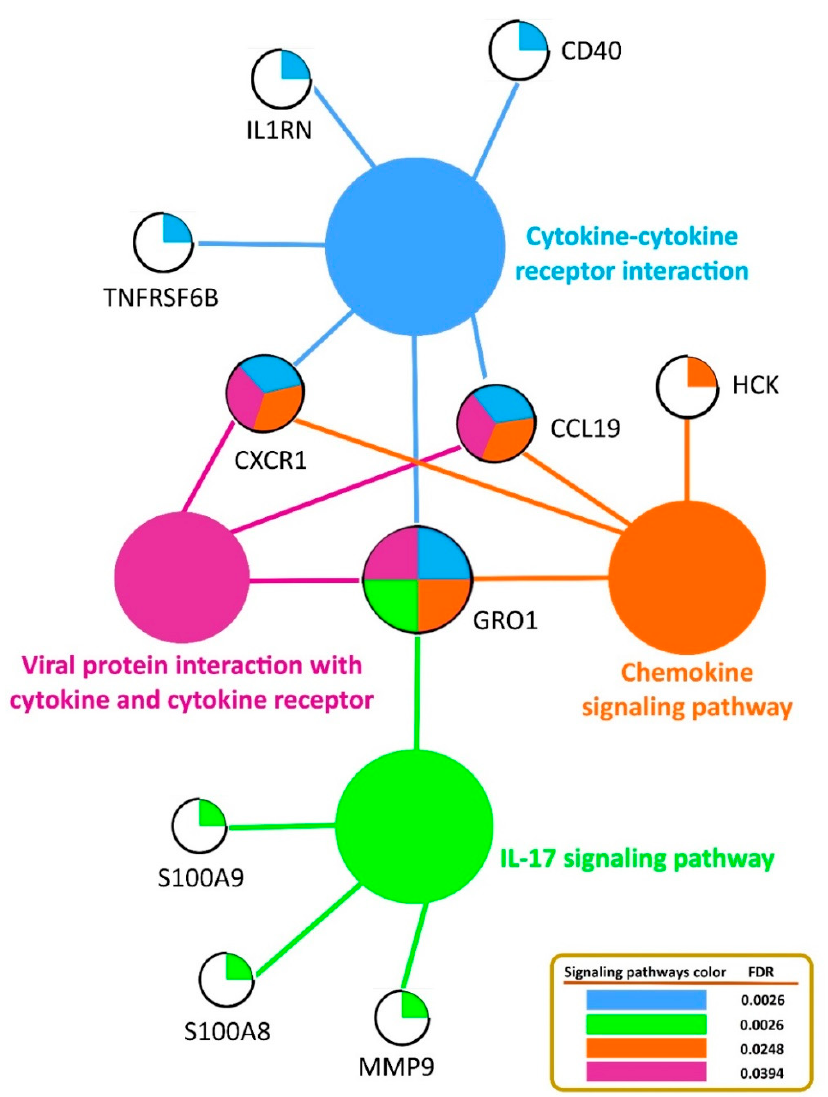
Figure 3. The KEGG pathway-based network analysis of significant genes related to mastitis in dairy cattle.